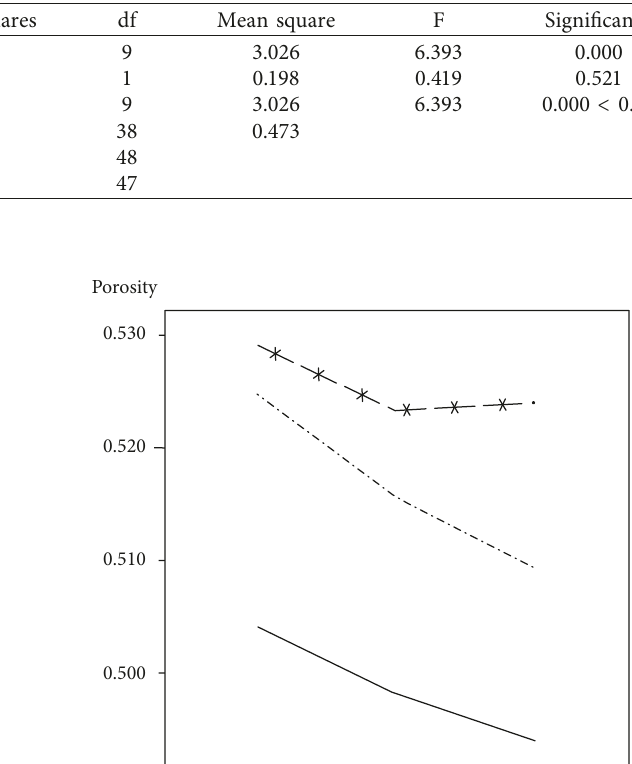
Table 5: Tests of between-subject effects.